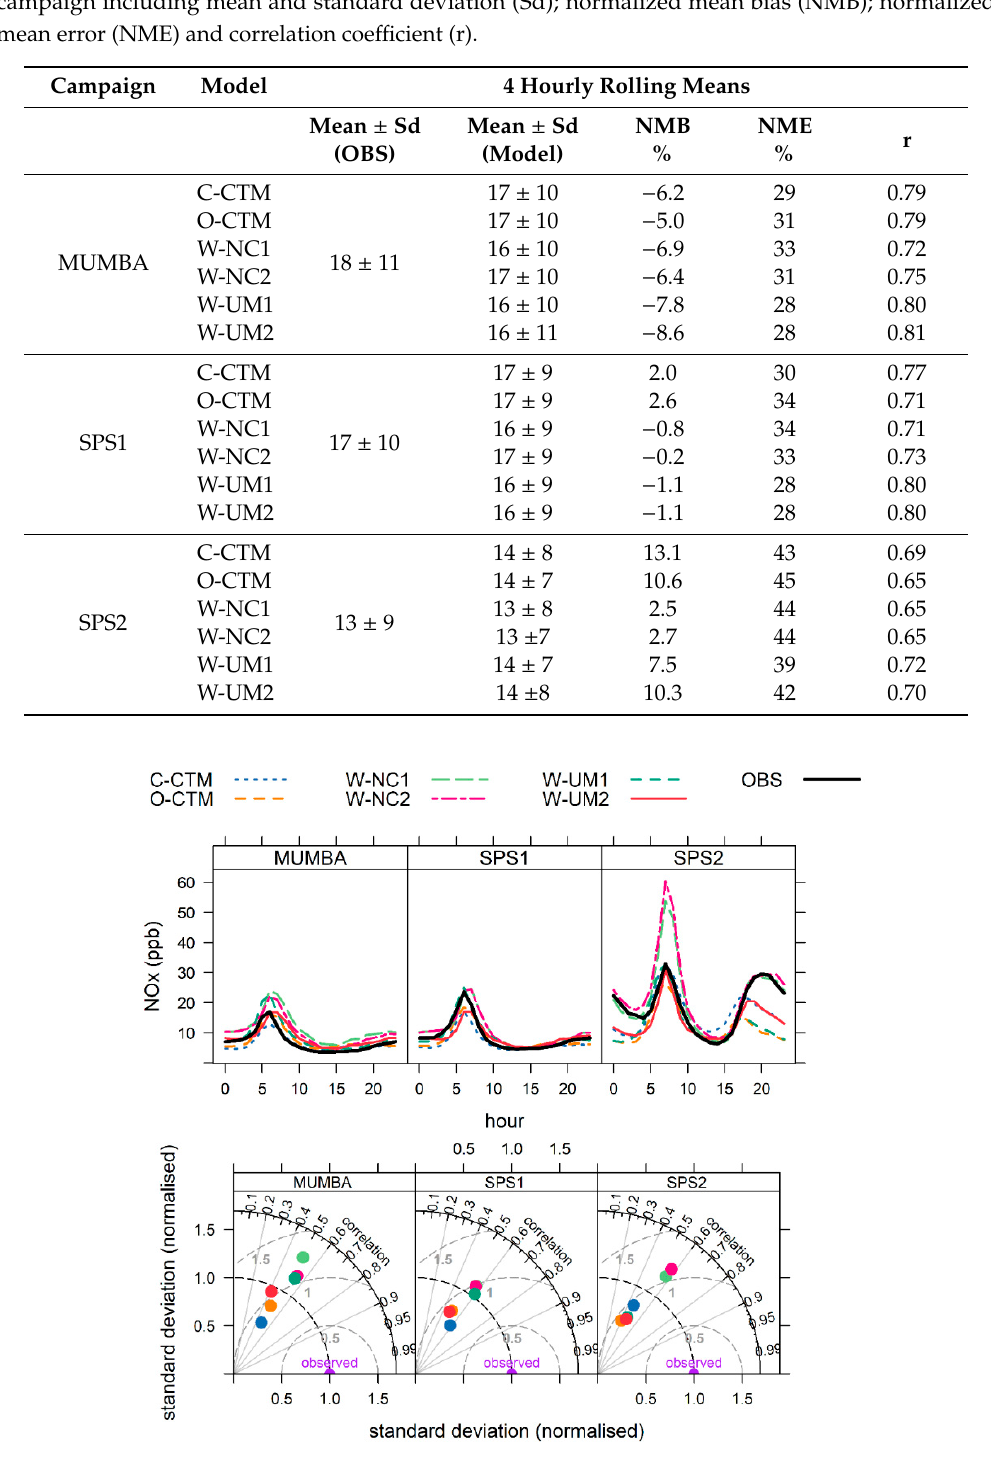
Figure A2. Taylor diagrams for O 3 4 hourly average values for each campaign period (upper panel) and mean bias for paired model/observed O 3 4 hourly average values, split into quantile bins (0–1, 1– 5, 5–10, 10–25, 25–50, 50–75, 75–90, 90–95, 95–99 and 99–100 percentiles) for observed values (lower panel).